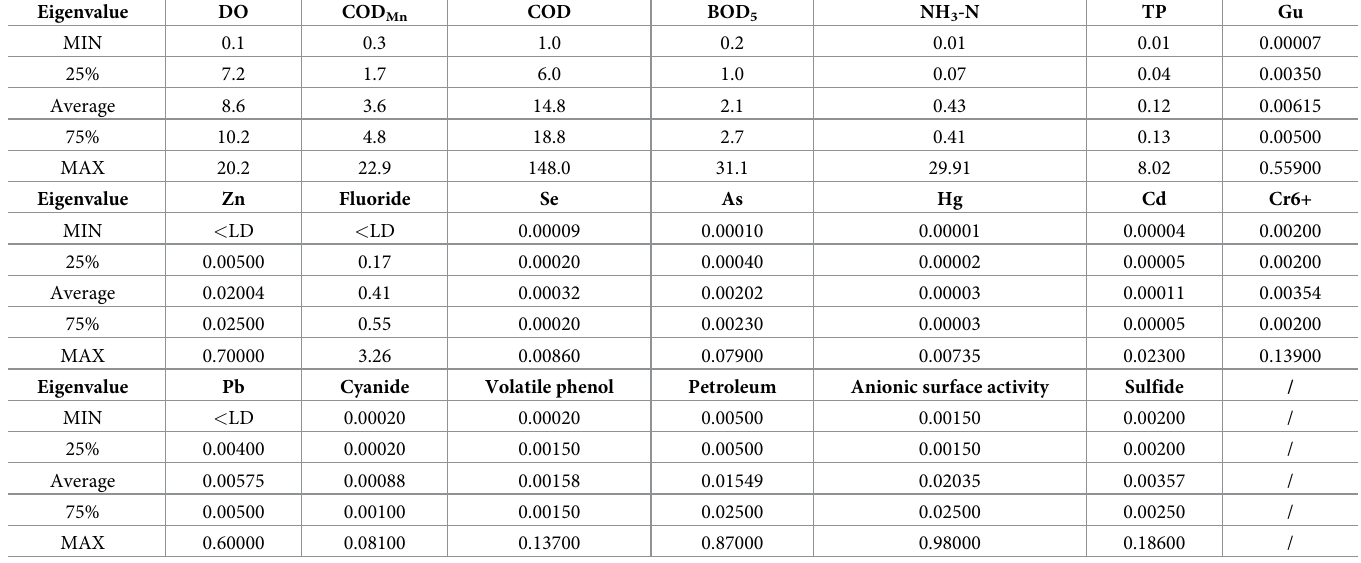
Table 4. Eigenvalue concentration value of water quality items in 2019